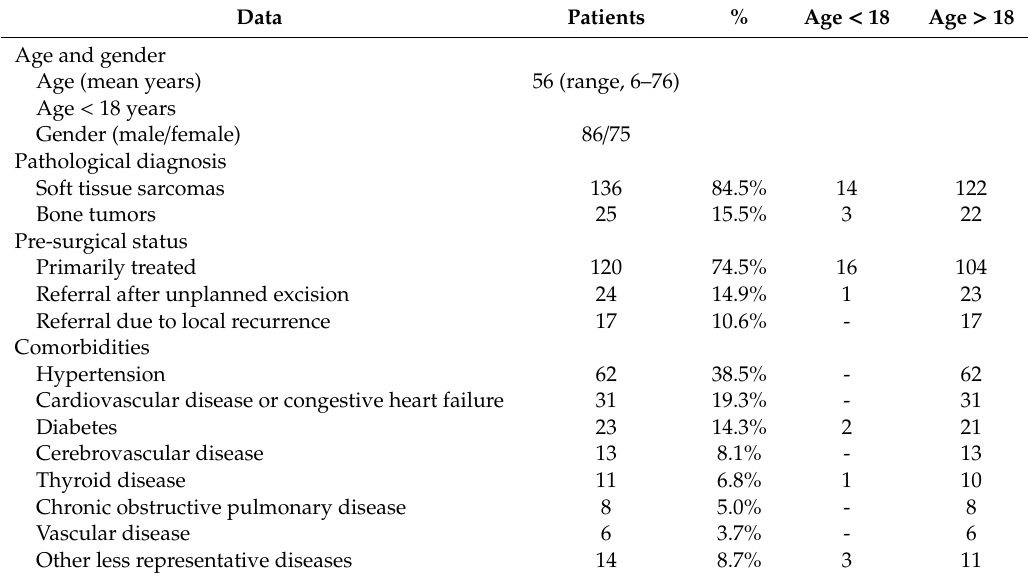
Table 1. Demographic data of entire series ( n = 161